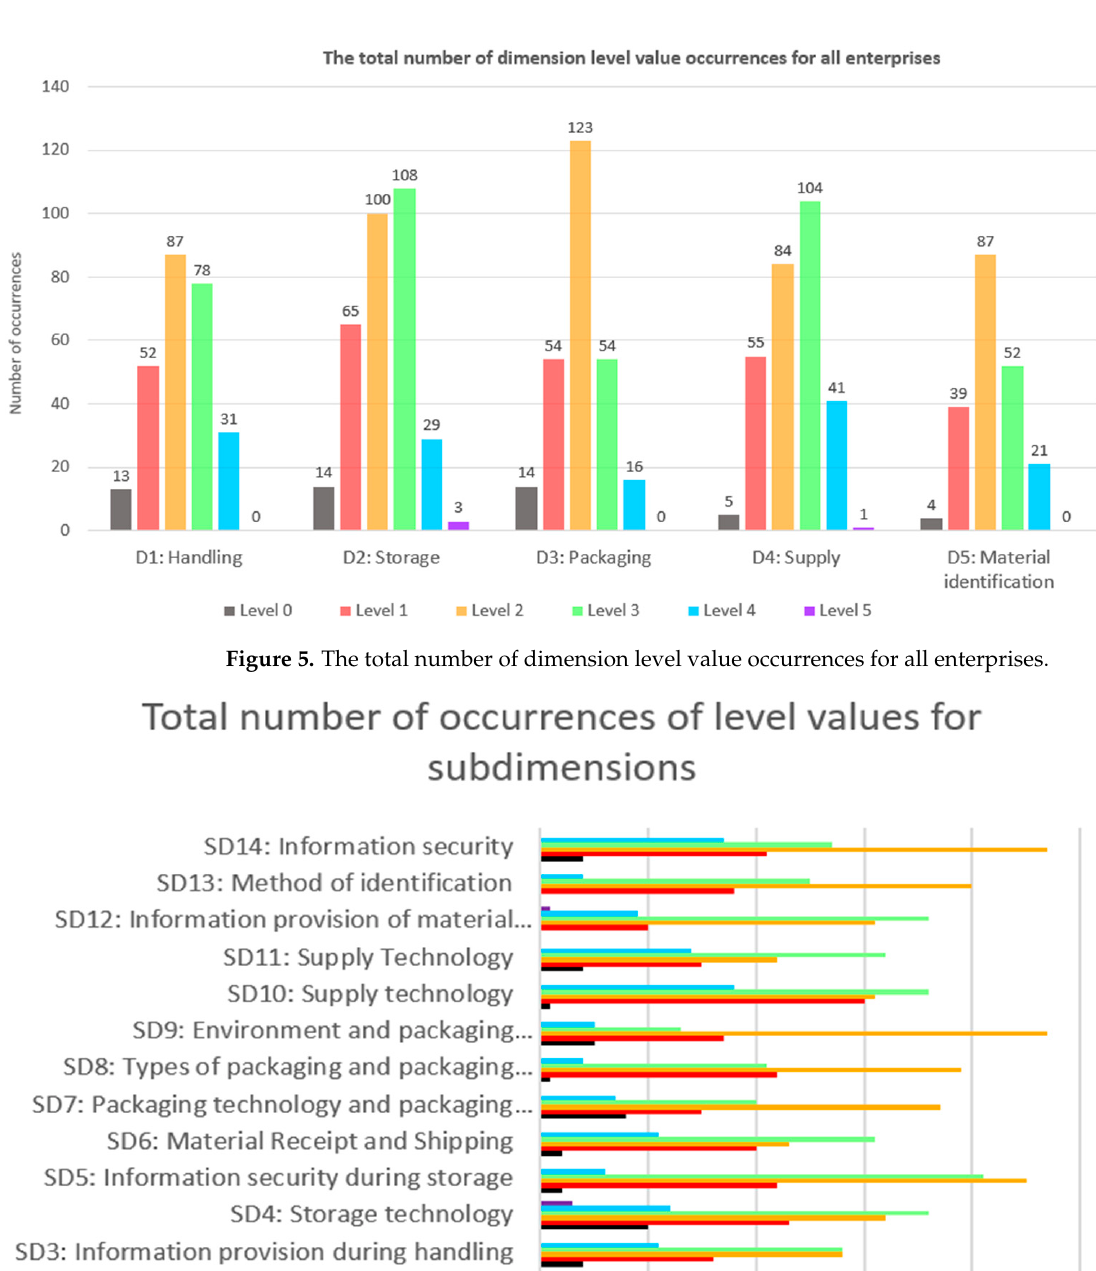
Figure 6. Total number of occurrences of subdimension level values for all enterprises.